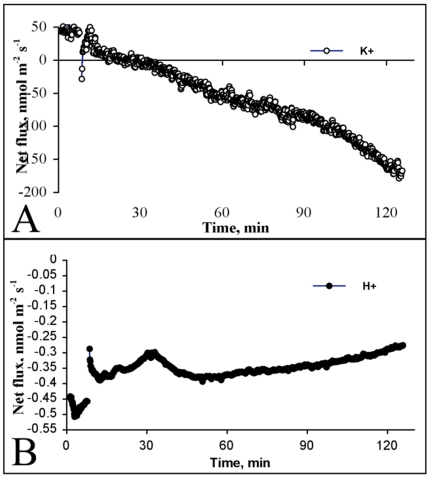
Soluble Aβ induces prolonged efflux of K+ in Tg2576 cortical neurons.Treatment with 1 µM Aβ1-40 triggered rapid efflux of K+ from Tg2576 neurons (A), which continued over the 120 minutes of recording. Aβ1-40 treatment caused a rapid influx of H+ in Tg2576 neurons (B), which did not stabilise over the 120 minute recording period.